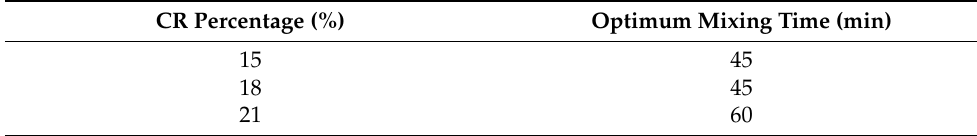
Table 3. Optimum mixing time for different percentages of CR.